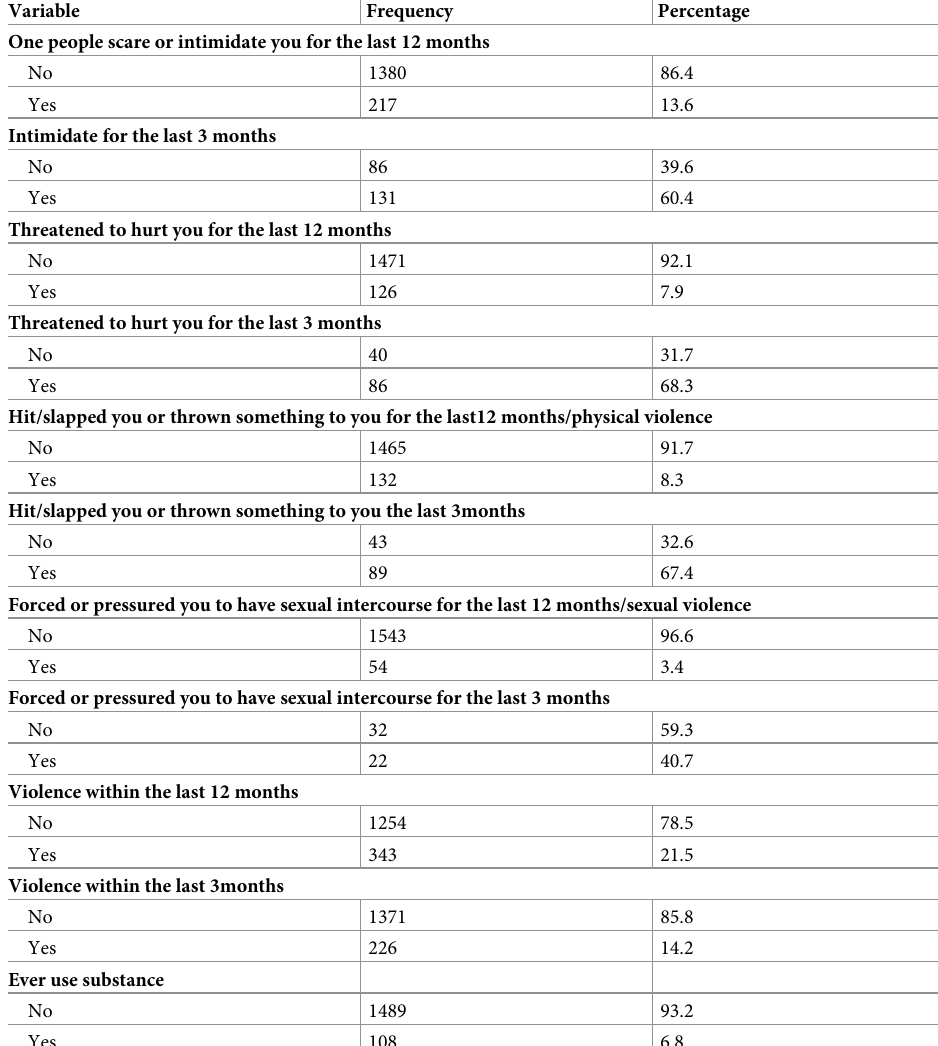
Table 2. Percentage of youth violence and their personal behavior Northwest,